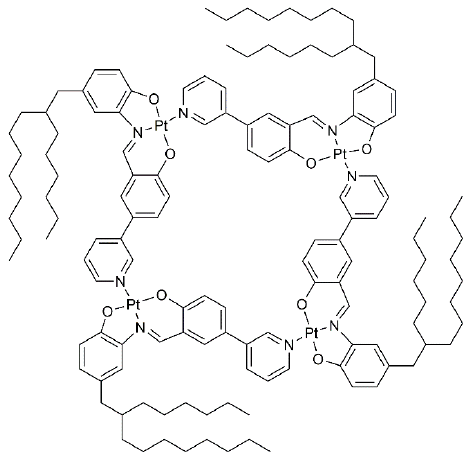
Figure 2. A tetranuclear metalla-cycle with lyotropic liquid-crystalline behavior [26].